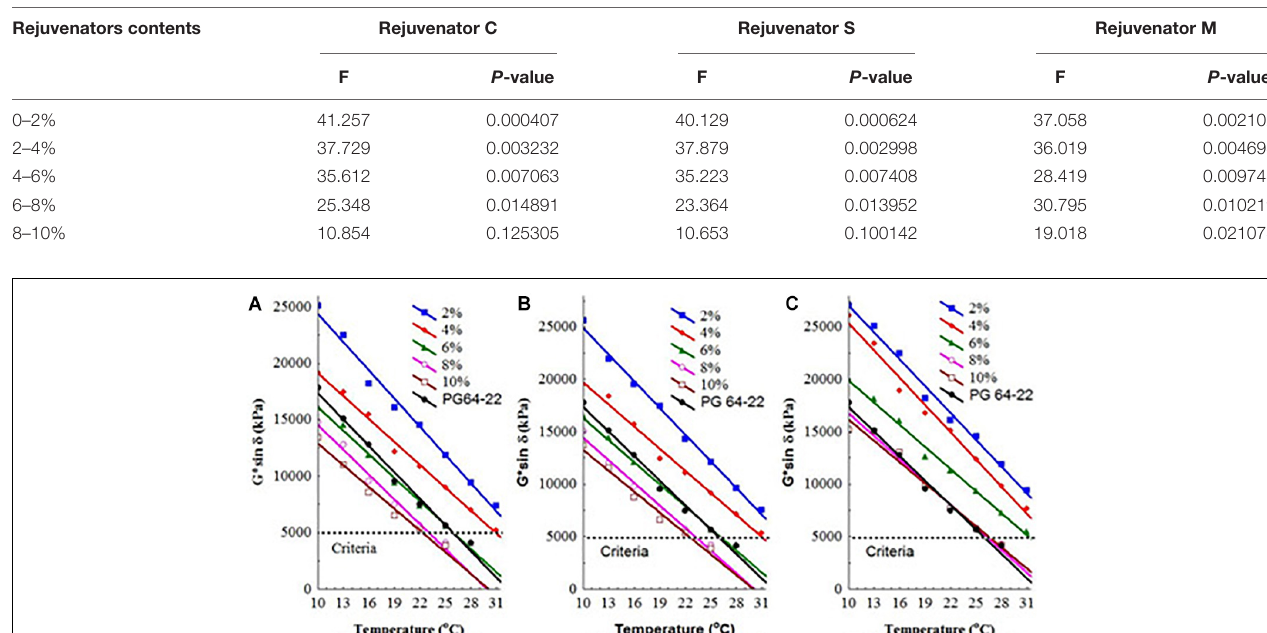
TABLE 7 | One-factor rejuvenator contents ANOVA on G*/sin δ of recovered bitumen ( α = 0.05).